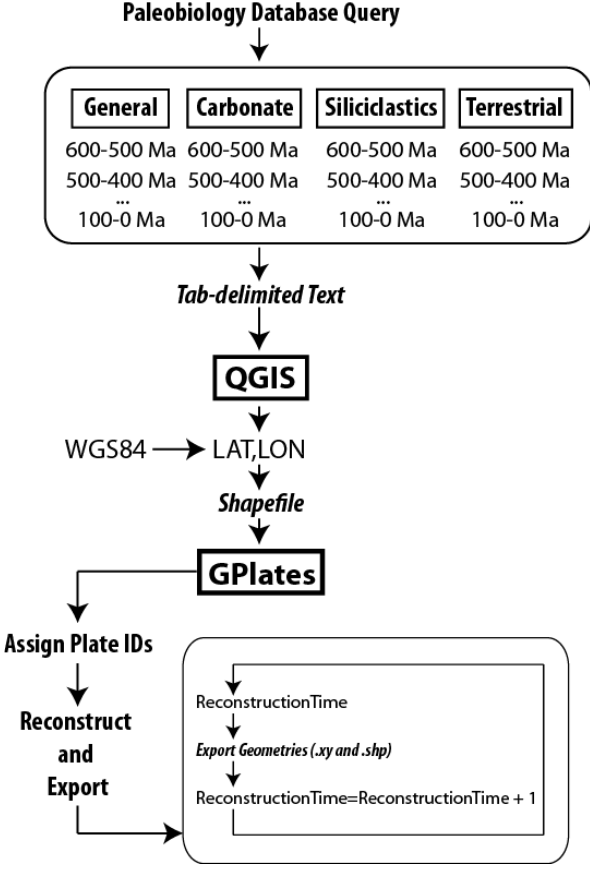
query results into GPlates -compatible files using QGIS . Continental Plate IDs are assigned to each fossil collection using continental block outlines, and the data is rotated in GPlates using our plate motion model for the Phanerozoic. Geometries were exported as simple ASCII and ESRI Shapefiles using the WGS 84